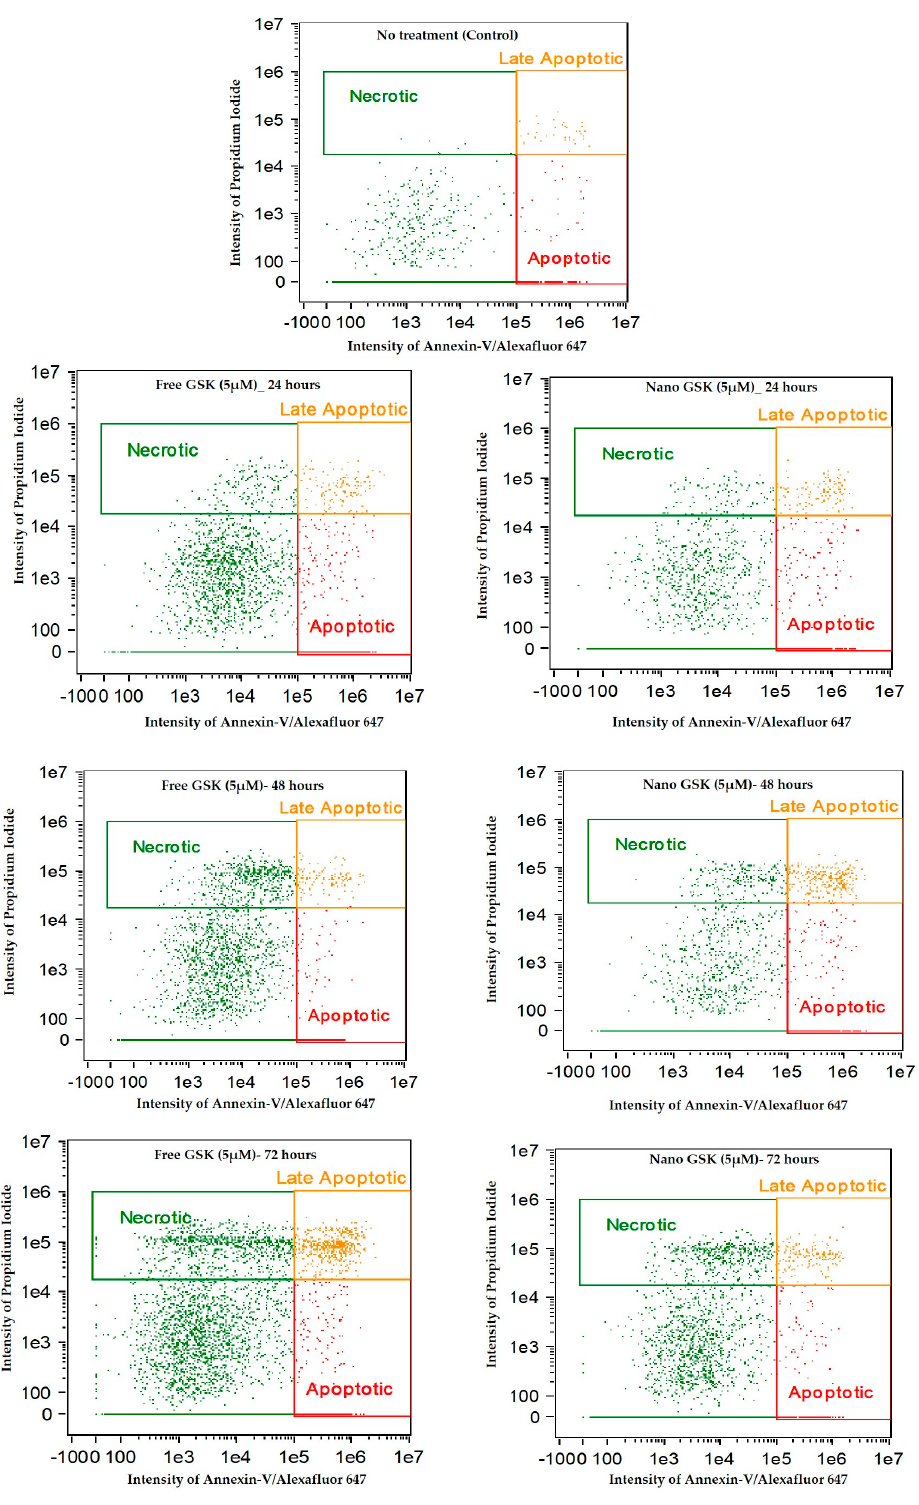
Figure 8. Annexin-V/Alexa Fluor™ 647 and Propidium iodide stained U87-MG cells post treatment with free and nano GSK (5 µM). Population of cells that are in early apoptosis, late apoptosis and necrosis at 24, 48 and 72 h are mentioned. The first row indicates cells that received no treatment.